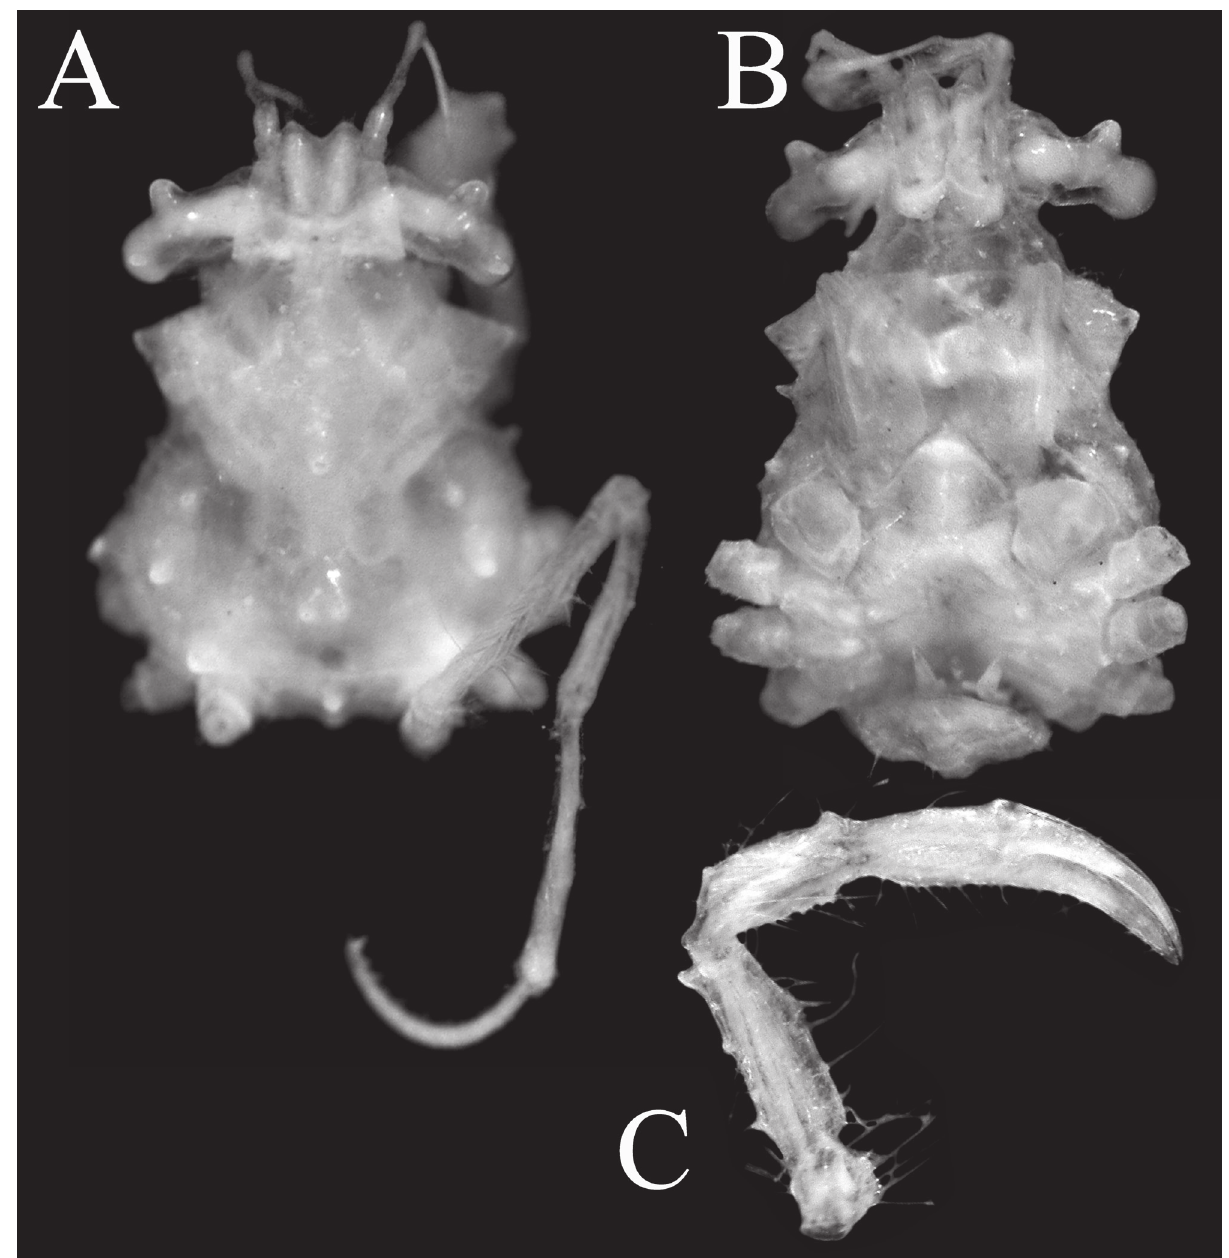
Figure 1. Achaeus umu n. sp., holotype female (1.9 × 2.7 mm) (USNM 1253231), Easter Island. A, dorsal view of carapace; B, ventral view of cephalothorax showing buccal cavity and anterior thoracic sternum; C, dorsal view of left